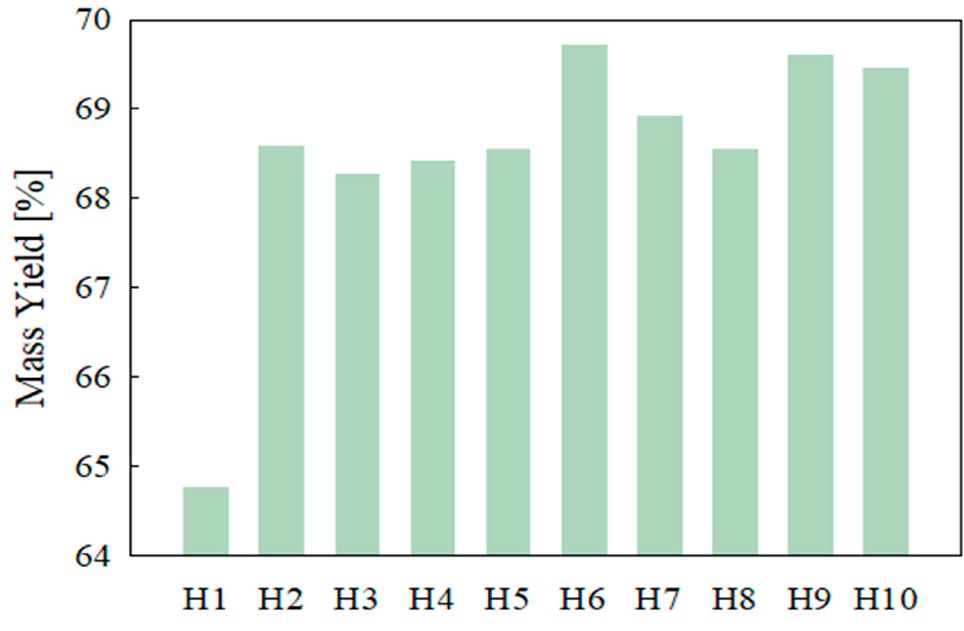
Figure 4. Mass yield of hydrochar.